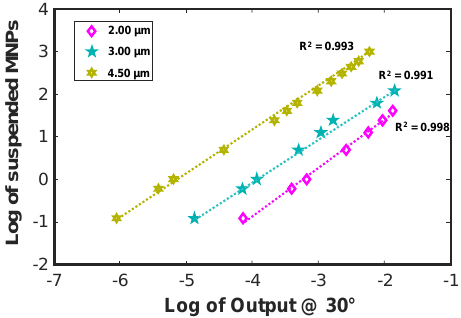
Fig. 4. The logarithm of MPs concentration in water versus the logarithm of scattering intensity at